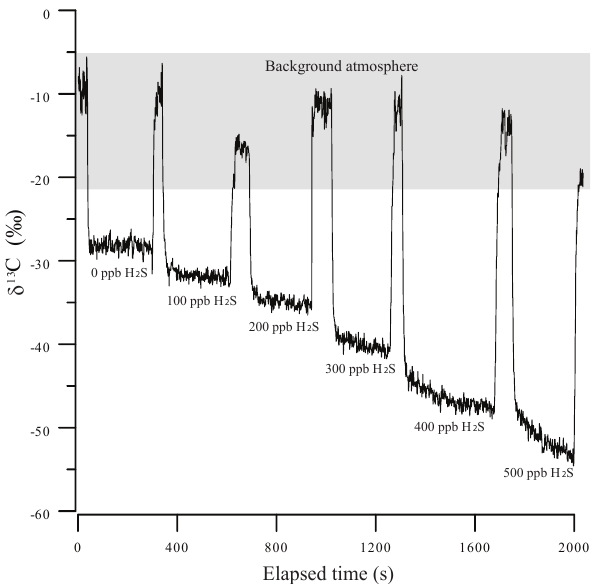
Figure 2. Raw carbon isotope signal from the Picarro G1101-i CRDS with varying amounts of H 2 S. Addition of H 2 S causes an increasingly negative response for the isotopic value. The raw iso- topic signal at each H 2 S concentration does not stabilize, but instead starts to slowly decrease resulting in a “sloped” response. Variations in background levels can be attributed to variations in laboratory conditions (i.e., respiration).